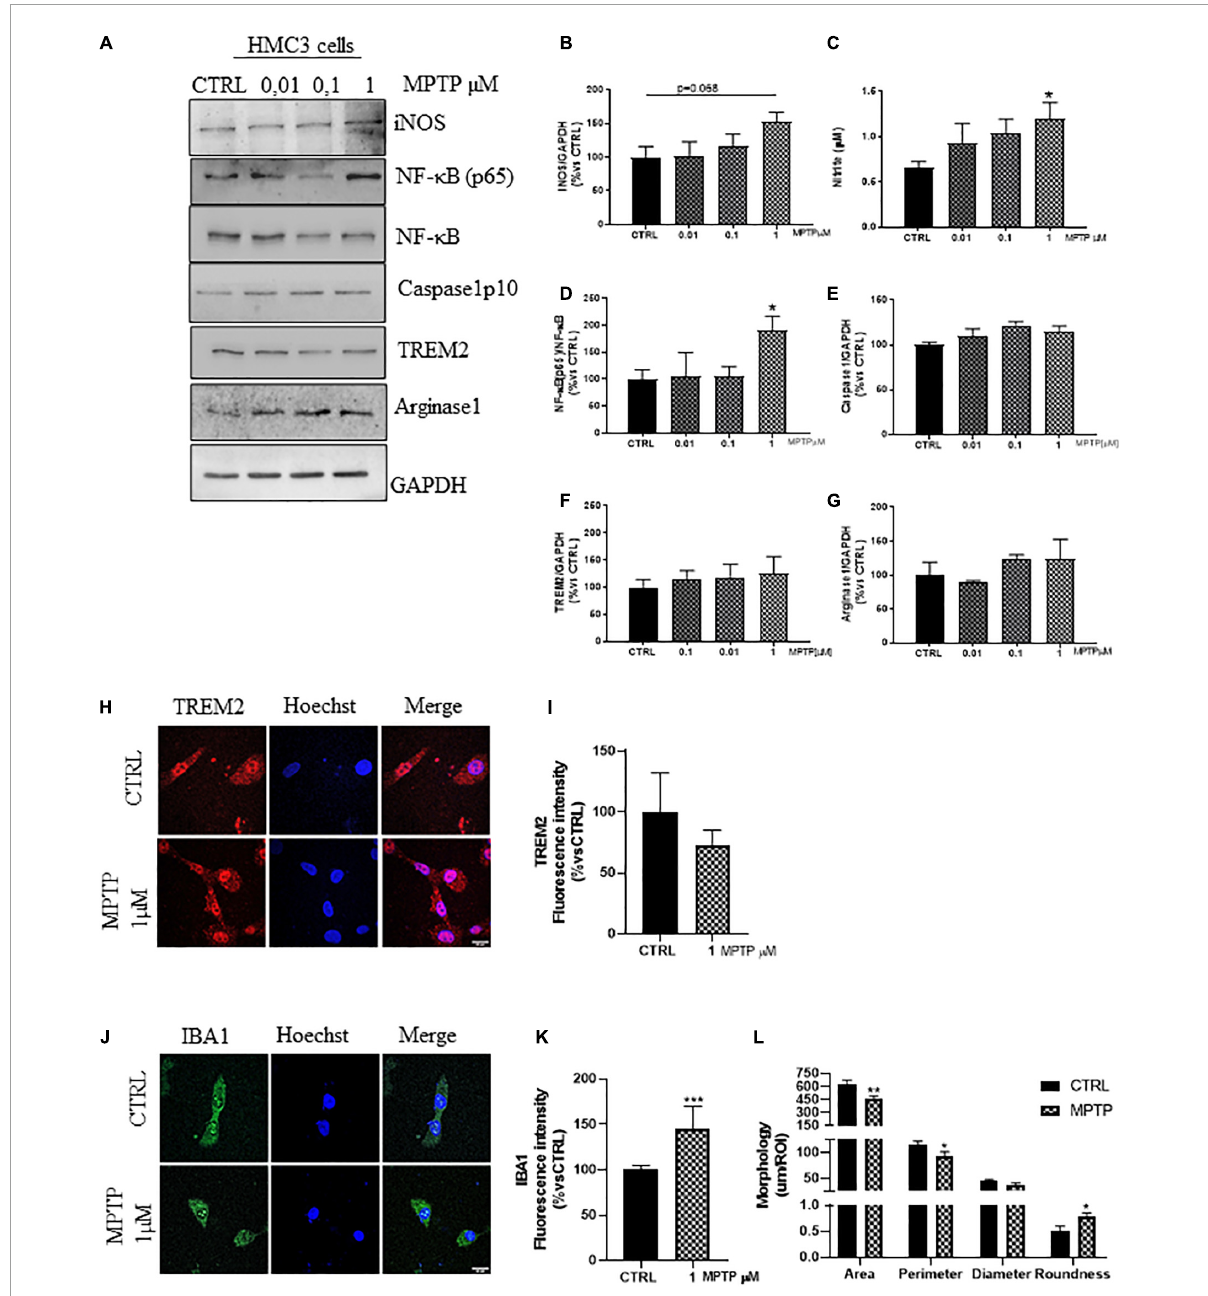
FIGURE3 Phenotypic markers expression in human microglial clone 3 cell line (HMC3) treated with increasing concentration of MPTP. Western blot analysis and relative densitometry of iNOS (A,B) , NF- κ B(p65)/NF- κ B (A,D) , (Prati et al., 2015) Caspase1p10 (A,E) , TREM2 (A,F) , Arginase1 (A,G) in lysed cells vs. the reference protein GAPDH and nitrite quantification in conditioned medium (C) of HMC3 cell treated with increasing concentration of MPTP (0, 0,01, 0,1, and 1 µ M) for 24 h. Results are the mean ± s.e. of three independent experiments. Representative immunofluorescence and relative quantification of fluorescence intensity of TREM2 (H,I) , and IBA1 (J,K) and morphology analysis of IBA1 cells (J,L) in HMC3 cells treated with MPTP 1 µ M for 24 h. N = 3. Scale bar = 20 µ M. One-way ANOVA, followed by Dunnett’s test * p < 0.05, ** p < 0.01, and *** p < 0.001 vs.